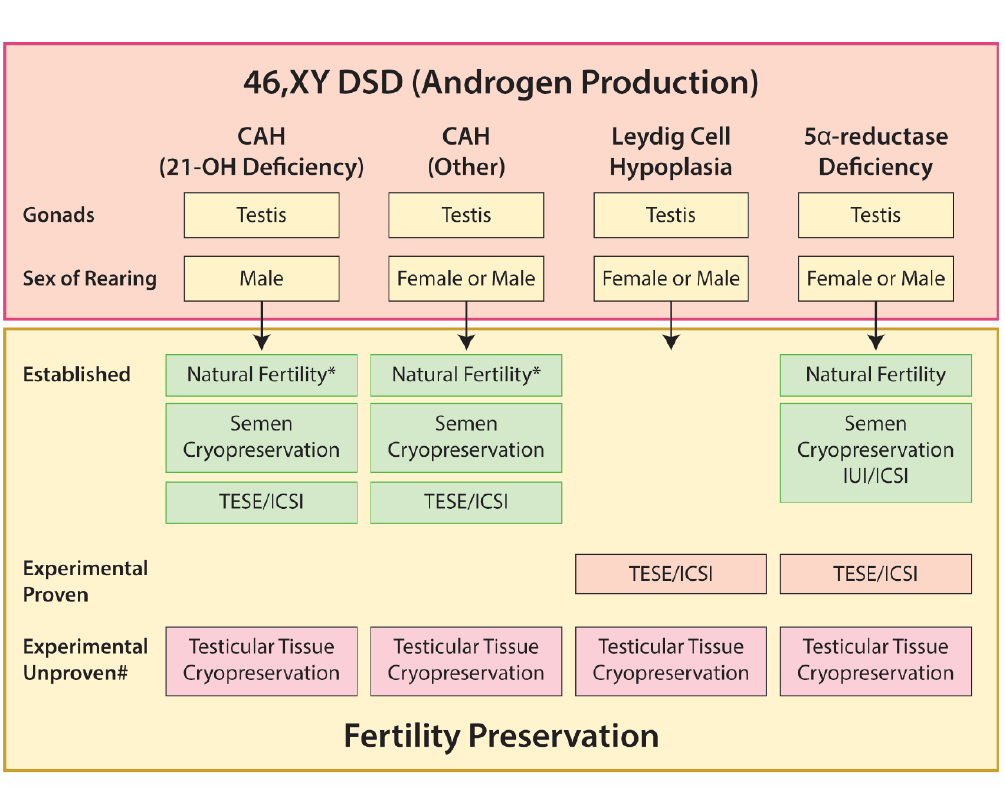
Figure 6. Options for fertility preservation in 46,XY DSD associated with impaired androgen production. * Optimise therapy for CAH. # Potential for gonadal tissue cryopreservation based